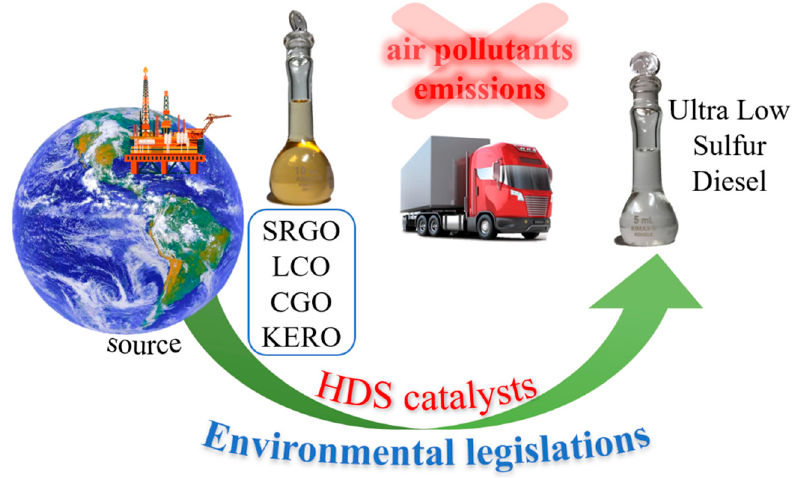
Figure 1 . Impacts on ultra-low sulfur diesel production. Figure 1. Impacts on ultra-low sulfur diesel